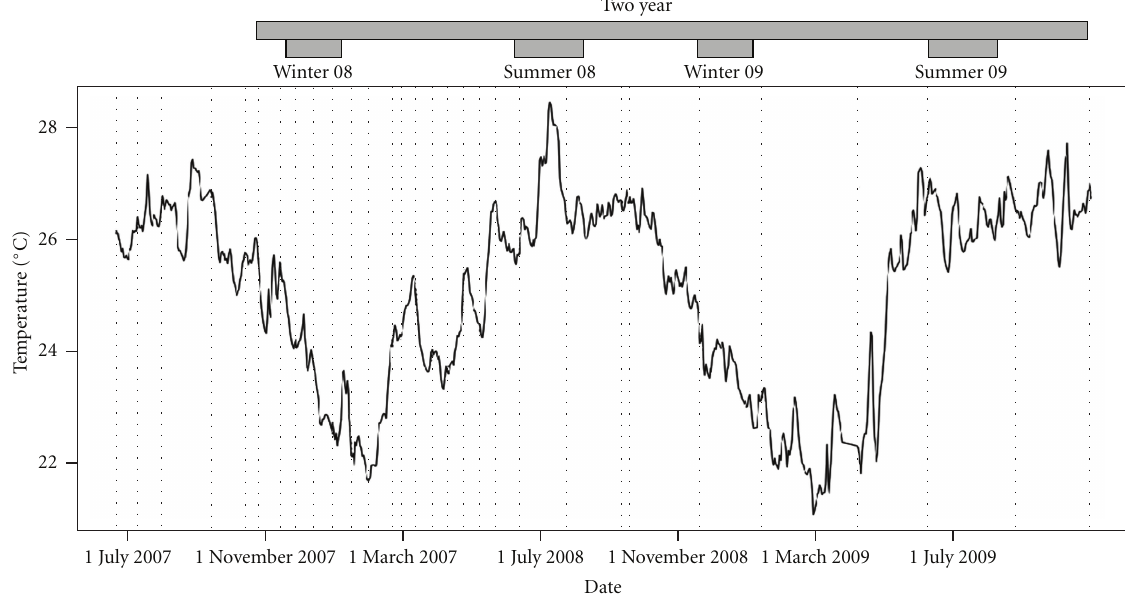
Figure 3: Temperature graph for the entire temperature data set (June 2007 to October 2008). Dashed vertical lines indicate deployment days when temperature data loggers in the field were collected and replaced. Bars above graph indicate the two-year and seasonal subsets that were used in the analyses.